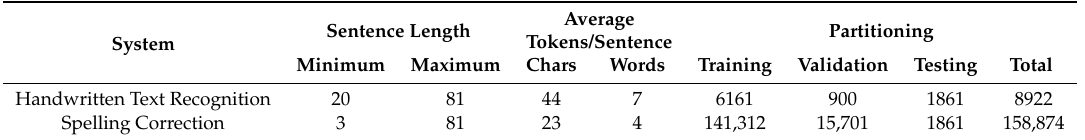
Table 2. Data distribution from IAM (Institut für Informatik und Angewandte Mathematik)